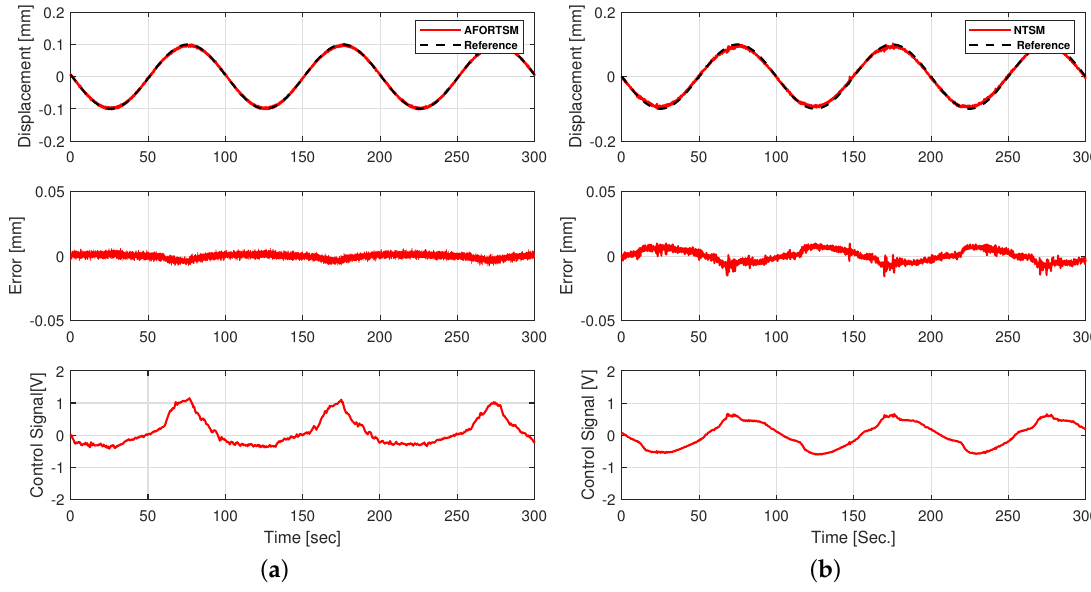
Figure 4. Test 3: Experimental results of AFORTSM and NTSM for tracking a single-tone sinusoidal reference without uncertainties (top: tracking profiles; middle: tracking error; bottom: control signal). ( a ) AFORTSM; ( b )